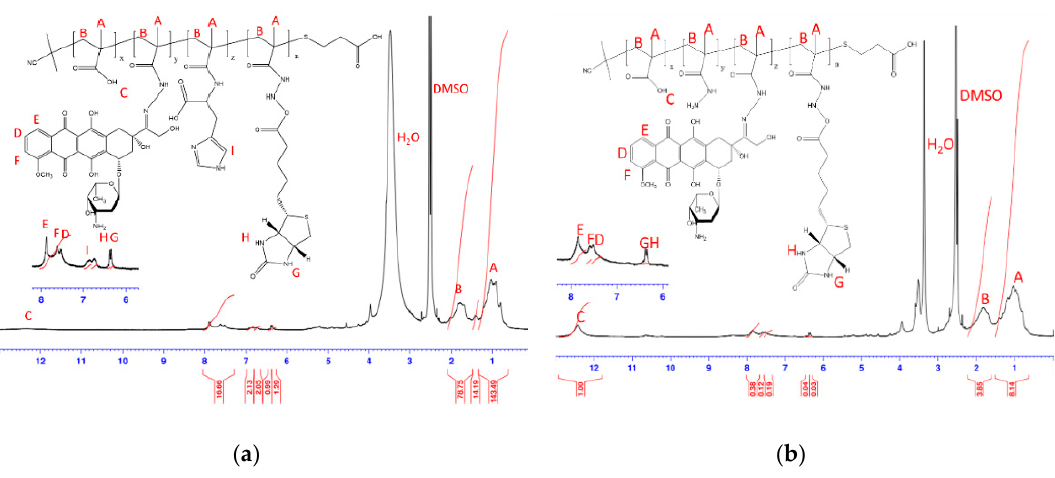
Figure 4. 1 H NMR spectrum of ( a ) HBD and ( b ) BD copolymers.